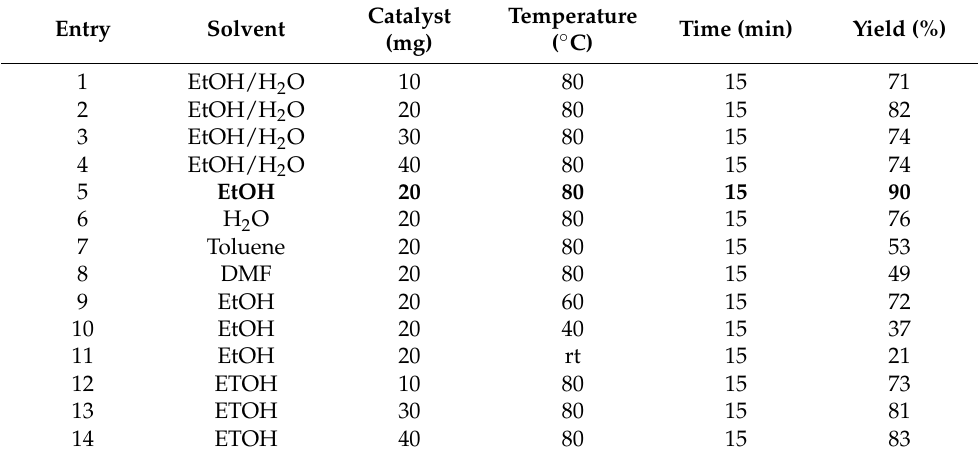
Table 1. Optimization of the reaction